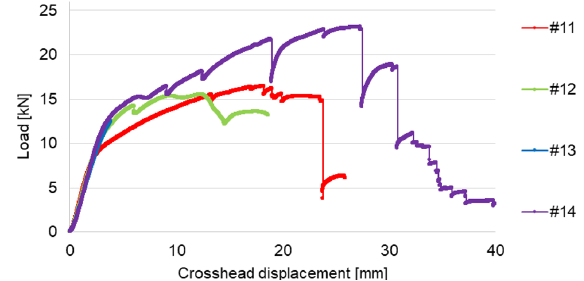
Figure 13. Load vs. crosshead displacement of the group two beams with the first failure F3 - parallel with the